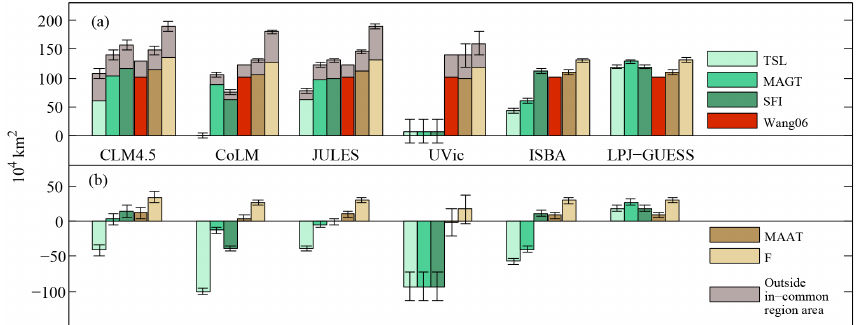
Figure 2. Permafrost areas derived from different diagnostic methods compared with the Wang06 map. (a) Permafrost area, with TP per- mafrost outside the common region denoted by grey extensions to the bars for CLM4.5, CoLM, JULES and UVic. (b) Bias in permafrost area “Model minus Wang06 estimate”, only for the common modeling region. The error bar is calculated as half of the averaged grid cell area of the model, so is model resolution